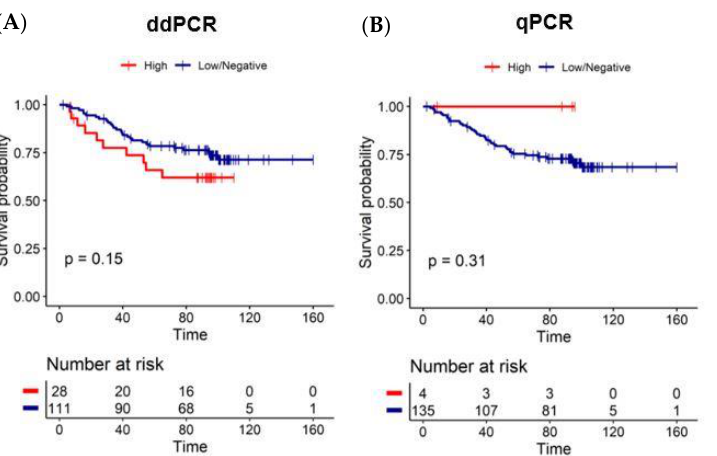
Figure 4. Kaplan–Meier curves for overall survival according to the method detection and the amount of Fn DNA and status of the FFPE CRC tissue. ( A ) Five-year overall survival is 58.3% for Fn high vs. 76.8% for Fn low/negative, detected by ddPCR (log-rank p = 0.15). ( B ) Five-year overall survival was 60.0% for Fn low/negative vs. 75.0% for Fn high detected by qPCR (log-rank p = 0.31).